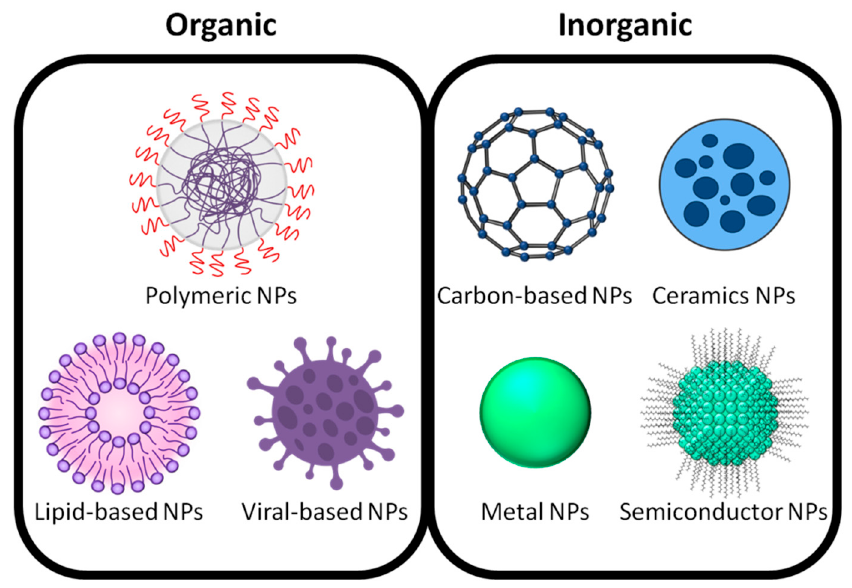
Figure 1. Different types of NPs. Organic NPs: polymeric NPs, lipid-based NPs, and viral-based NPs; inorganic NPs: carbon-based NPs, metallic NPs, ceramic NPs, and semiconductor